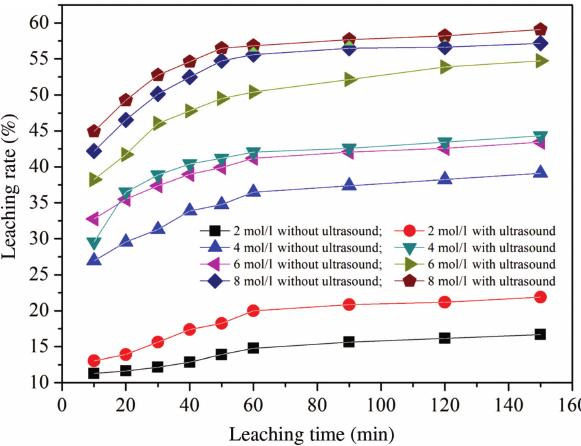
Figure 3: The effects of ammonia concentrations on zinc leaching